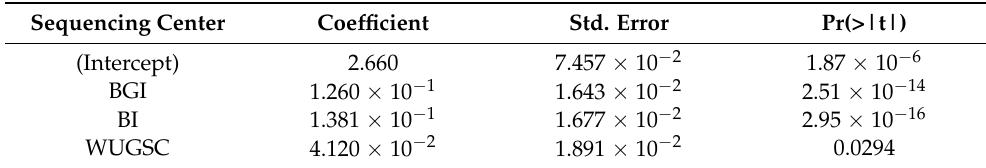
Figure 1. Symmetric correspondence analysis between the 1000G populations (blue) and the sequencing center (red). The expected result of the correspondence analysis in the absence of batch effect is the a group with all the populations roughly equidistant from the different sequencing centers. In this case, some of the populations are closer to a particular sequencing center. Acronyms are showed in Supplementary Materials Table S1. Table 1. Coefficient, standard error, and p value of the coefficient from the hierarchical mixed model using the number of LoF variants as the dependent variable and the sequencing center as the independent variable. For this analysis, we only considered sequencing centers that sequenced samples across all